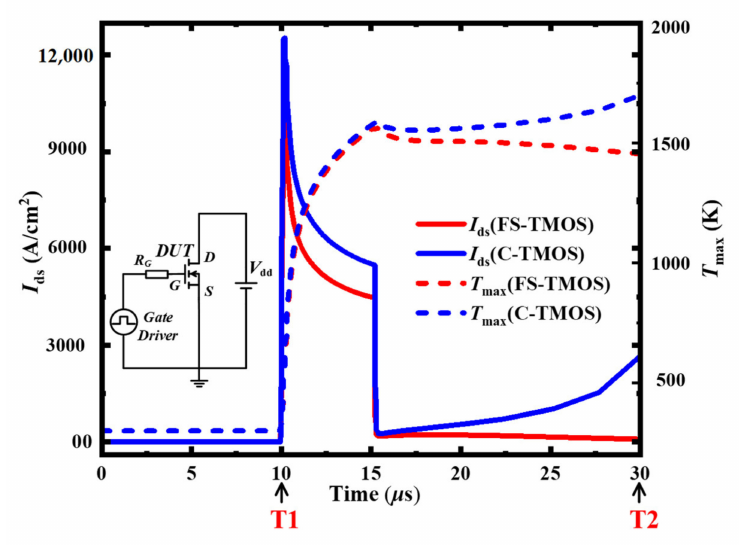
Figure 8. Short-circuit waveforms of FS- and C-TMOS under 600 V DC bus voltage. The T max means the maximum temperature inside the FS- and C-TMOS at each time point.